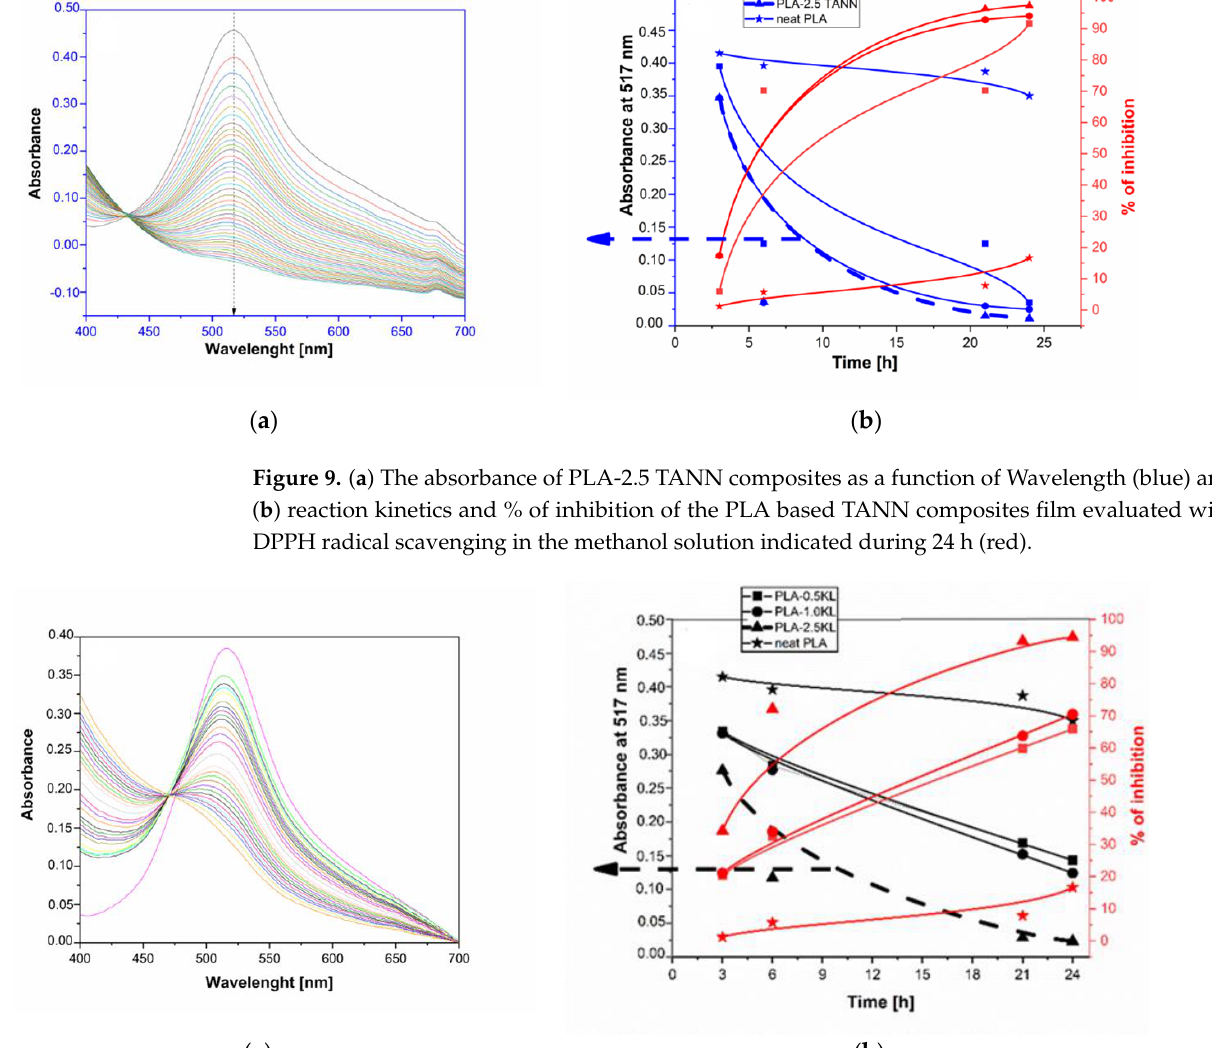
Figure 10. ( a ) The absorbance of PLA-KL composites as a function of Wavelength and time, ( b ) reaction kinetics of the PLA based KL composites film evaluated with DPPH radical scavenging in the methanol solution indicated during 24 h.